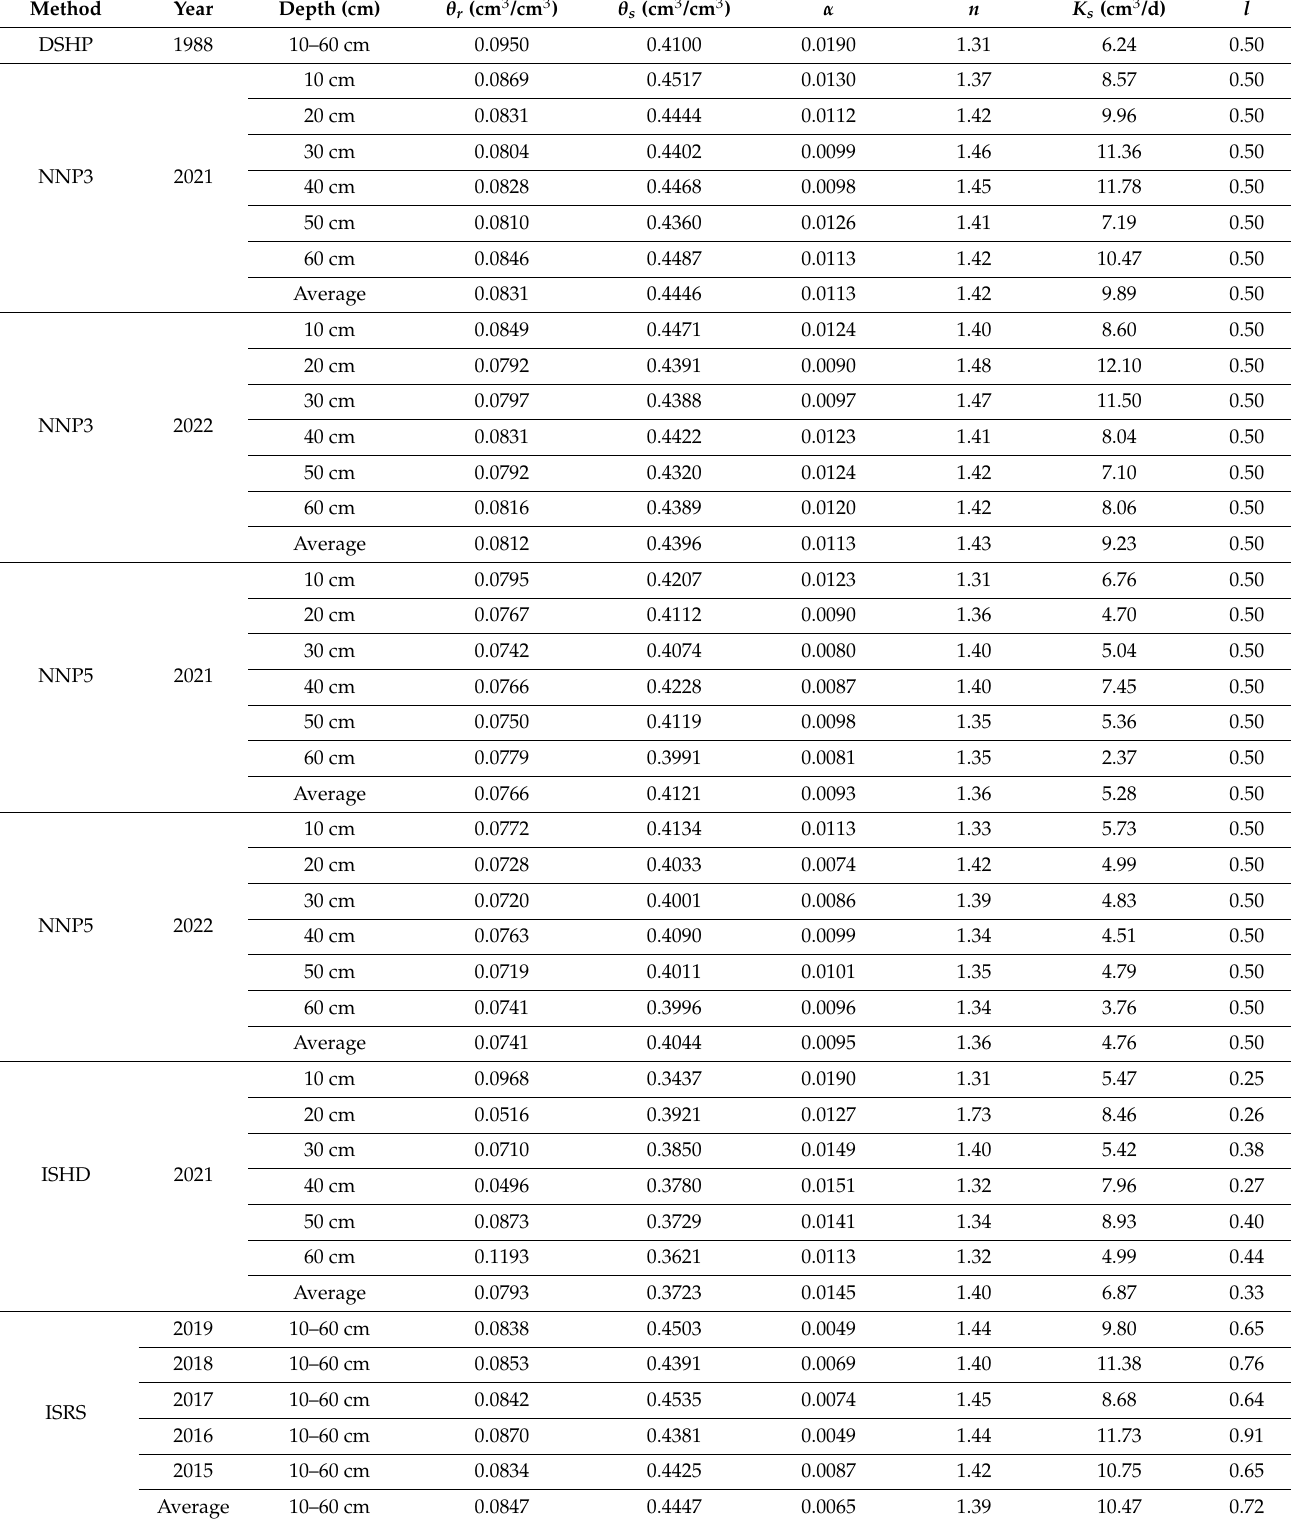
Table 6. Soil hydraulic parameters obtained by multiple